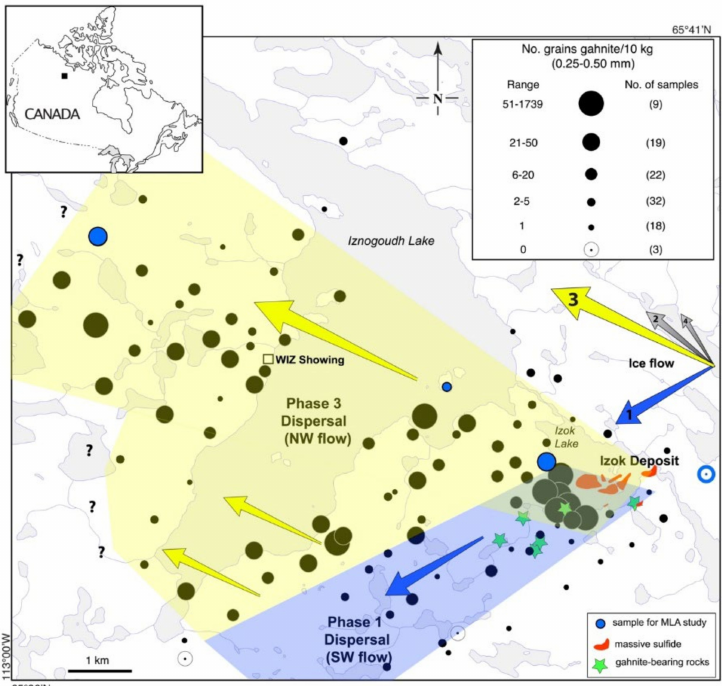
Figure 8. Fan-shaped glacial dispersal of gahnite abundance in the 0.25–0.5 mm fraction of till (normalized to a 10 kg) down-ice of the Izok Lake volcanogenic massive sulphide deposit in northern Canada. The fan formed by two phases of ice flow towards the southwest (blue polygon) and northwest (yellow polygon). Arrows indicate relative ice-flow chronology (1 = oldest) and vigor (arrow size) of flow events. Blue dots indicate the four till samples for which the <0.25 mm heavy mineral fraction was examined using MLA. Modified from McClenaghan et al. (2015 [24]). Location of mineralization indicated by solid red polygons and additional gahnite-bearing rocks by green